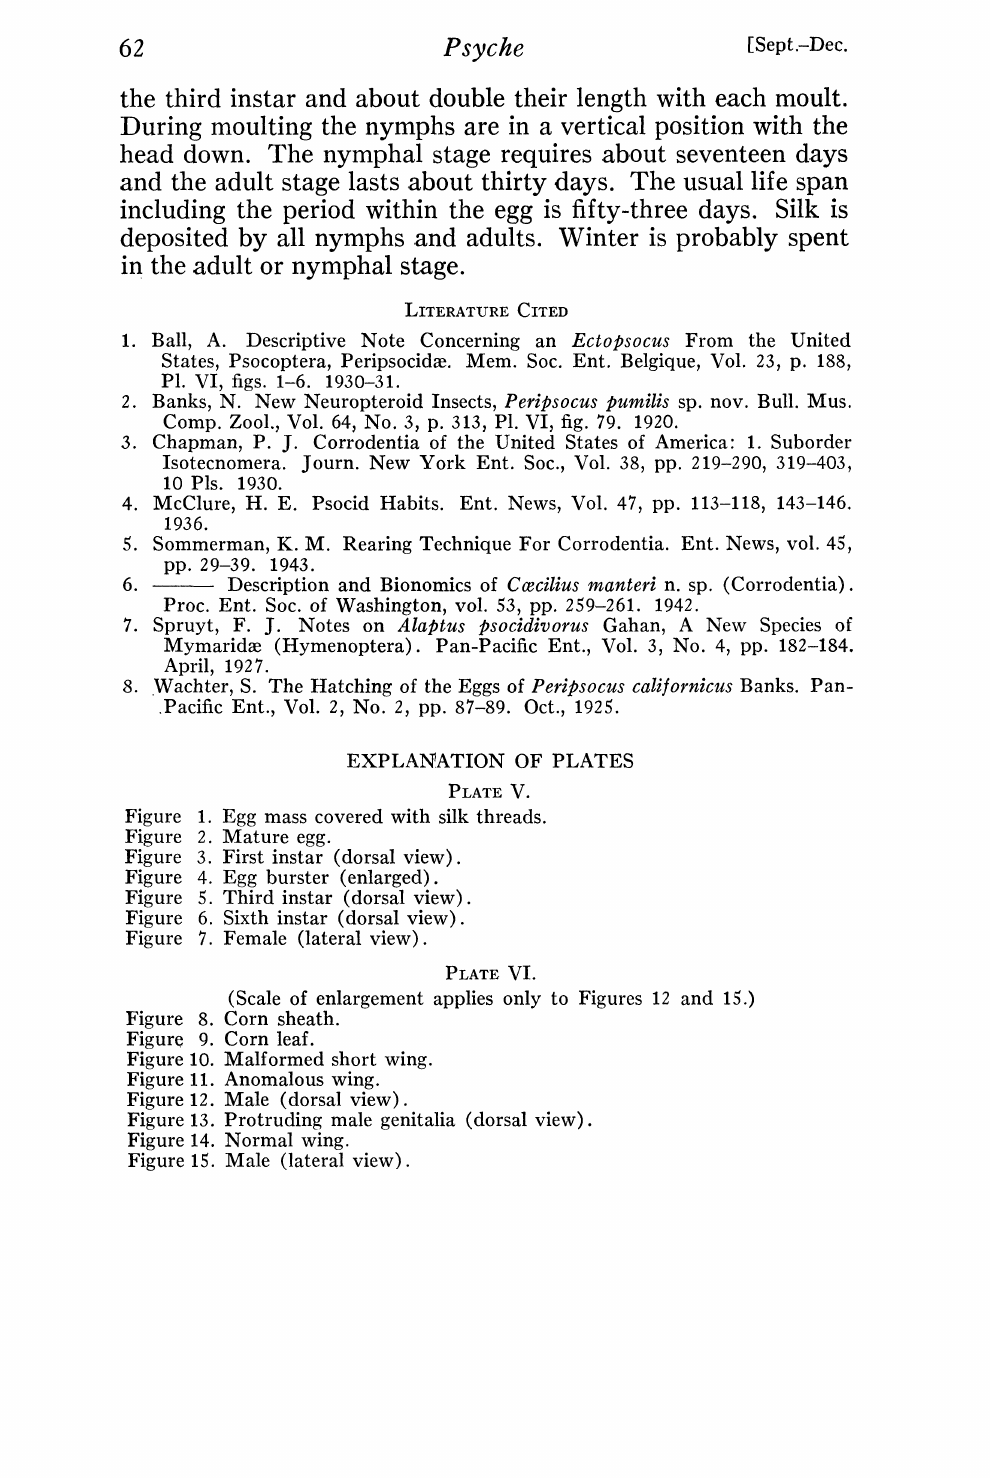
PLATE V. Figure 1. Egg mass covered with silk threads. Figure 2. Mature egg. Figure 3. First instar (dorsal view). Figure 4. Egg burster (enlarged). Figure 5. Third instar (dorsal view). Figure 5. Sixth instar (dorsal view). Figure 7. Female (lateral view). PLATE VI. (Scale of enlargement applies only to Figures 12 and 15.) Figure 8. Corn sheath. Figure 9. Corn leaf. Figure 10. Malformed short wing. Figure 11. Anomalous wing. Figure 12. Male (dorsal view). Figure 13. Protruding male genitalia (dorsal view). Figure 14. Normal wing. Figure 15. Male (lateral